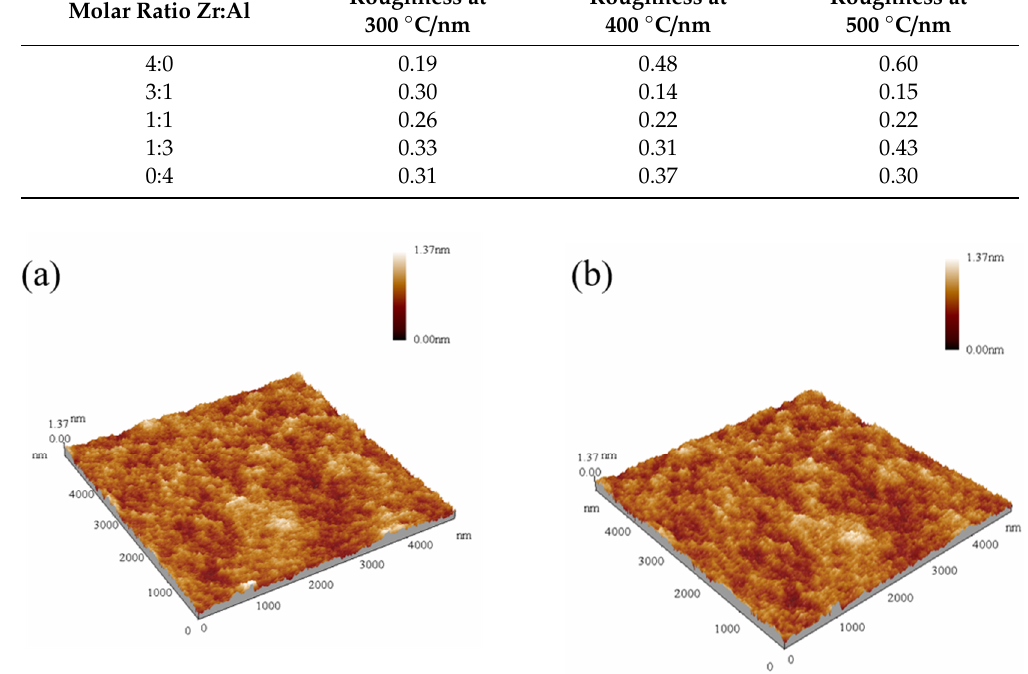
Figure 9. The AFM images of the ZAO films with a ratio of Zr:Al = 3:1 annealed at ( a ) 400 ° C and ( b ) 500 ° C.